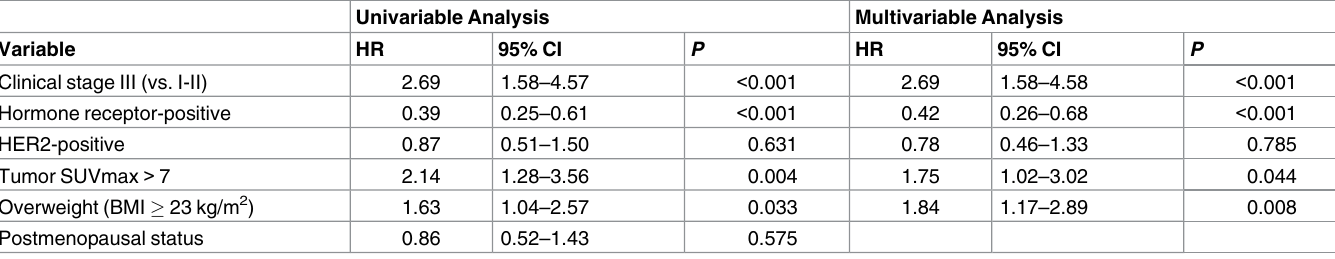
Table 2. Univariable and multivariable Cox regression analysis of recurrence-free survival (n =